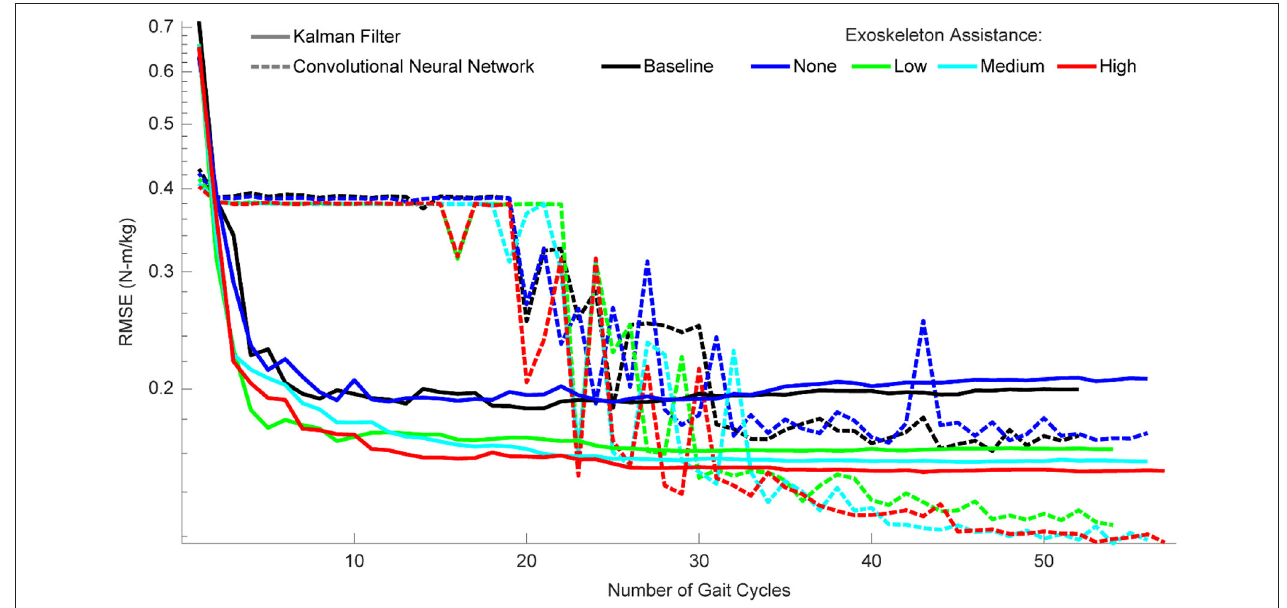
FIGURE 8 | Algorithm performance as a function of the number of gait cycles trained on. Performance is shown as RMSE (N-m/kg) of algorithm predictions relative to the ground truth values of right and left hip torque in the sagittal plane. For the KF, training data should consist of a minimum of three gait cycles, and little improvement is seen after ten gait cycles. For the CNN, at least 20 gait cycles are necessary for the algorithm to begin improving, and at least 35 gait cycles are needed to reliably outperform the KF. CNN performance continues to improve with additional gait cycles, but only if those gait cycles involve some level of exoskeleton assistance.